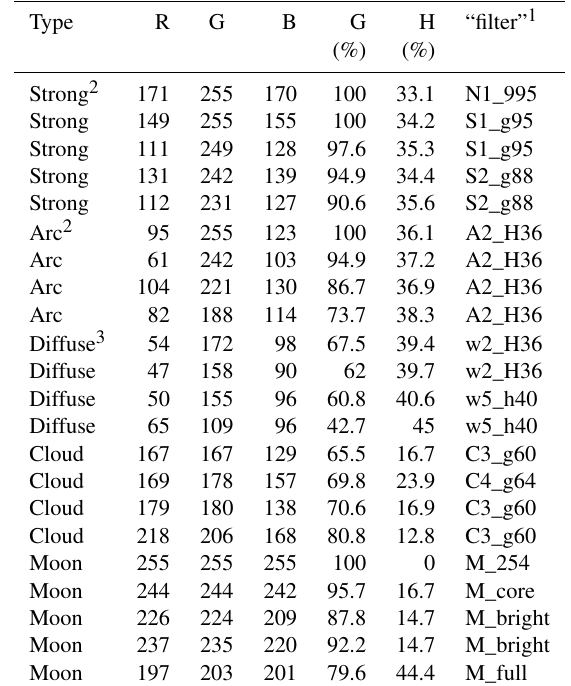
Table 1. Example of manual classification and color values of pix- els from an ASC image (18 October 2022 at 22:09UT, exposure time = 2s; Fig.